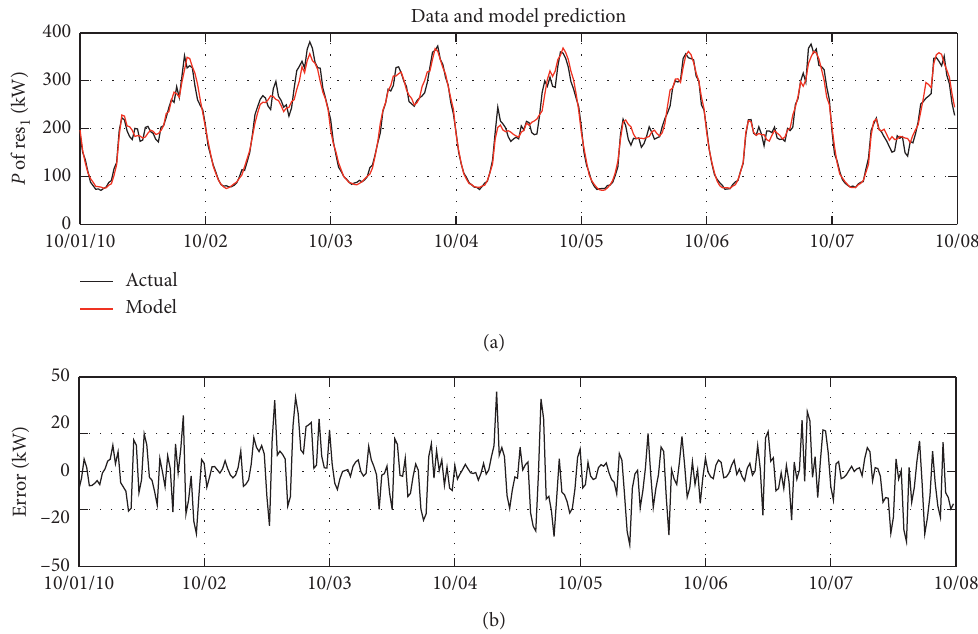
Figure 10: Detail of the first test week related to res represents the actual one; (b) the corresponding error in kW.